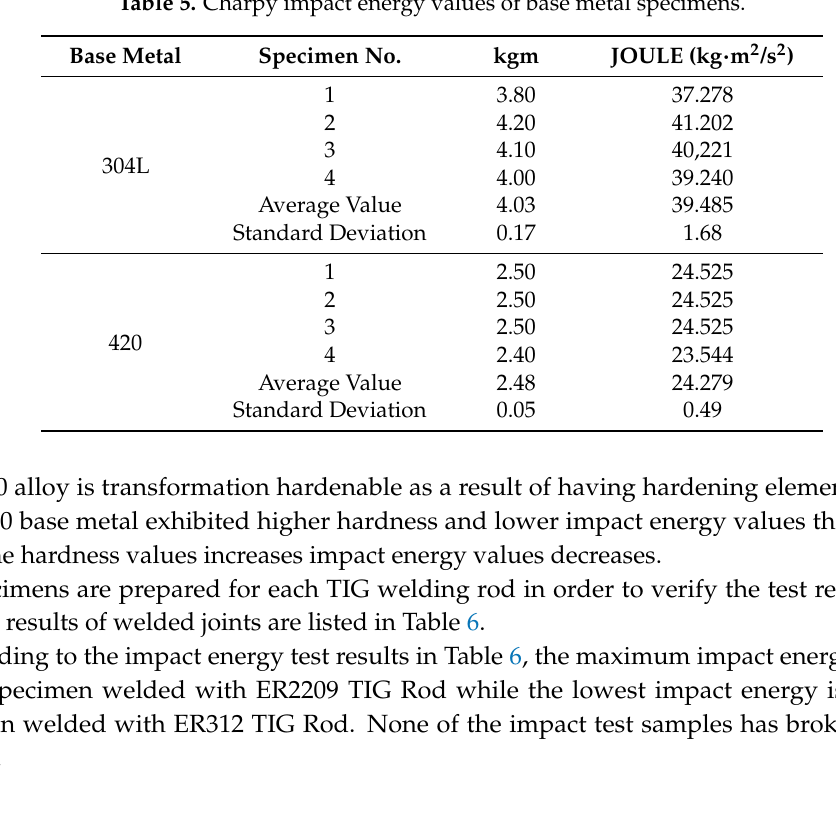
Table 5. Charpy impact energy values of base metal specimens.